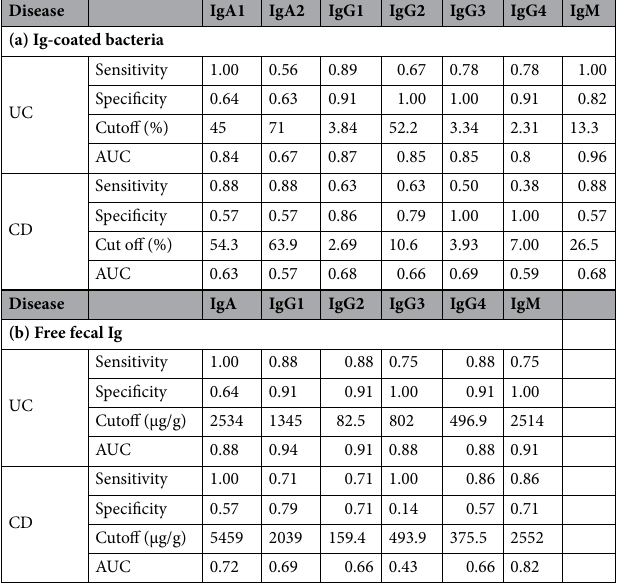
Table 2. Use of Ig-coated bacteria and free fecal Ig as a predictor of disease activities. UC Ulcerative colitis, CD Crohn’s disease, AUC Area under the